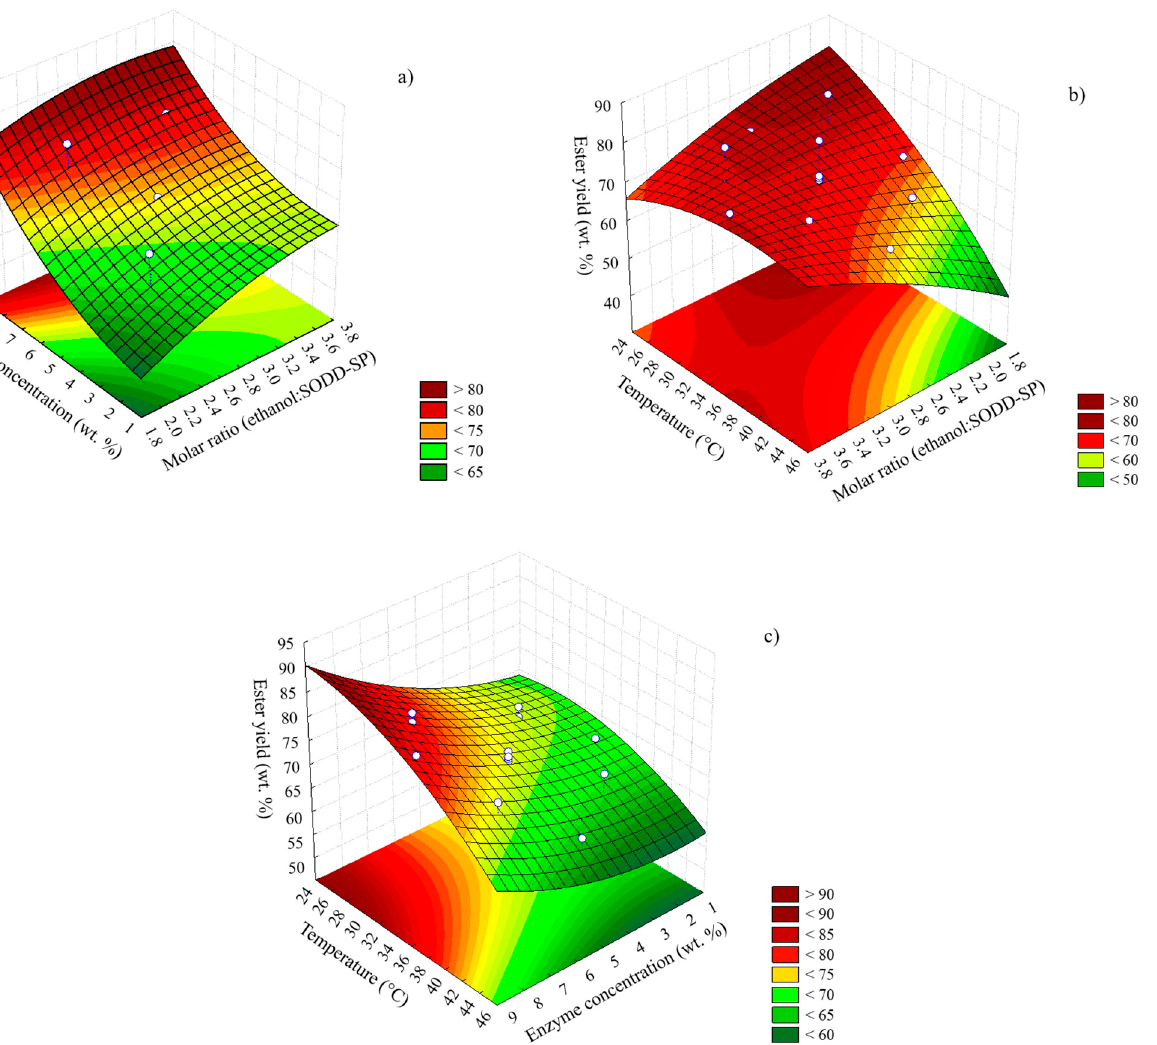
Figure 2. Response surfaces of biodiesel reaction with SODD saponifiable phase (SODD-SP). ( a ) Enzyme concentration vs. ethanol:SODD-SP molar ratio. ( b ) Temperature vs. ethanol:SODD-SP molar ratio. ( c ) Temperature vs. enzyme concentration. Z-axis indicates the ester yield (wt. %).